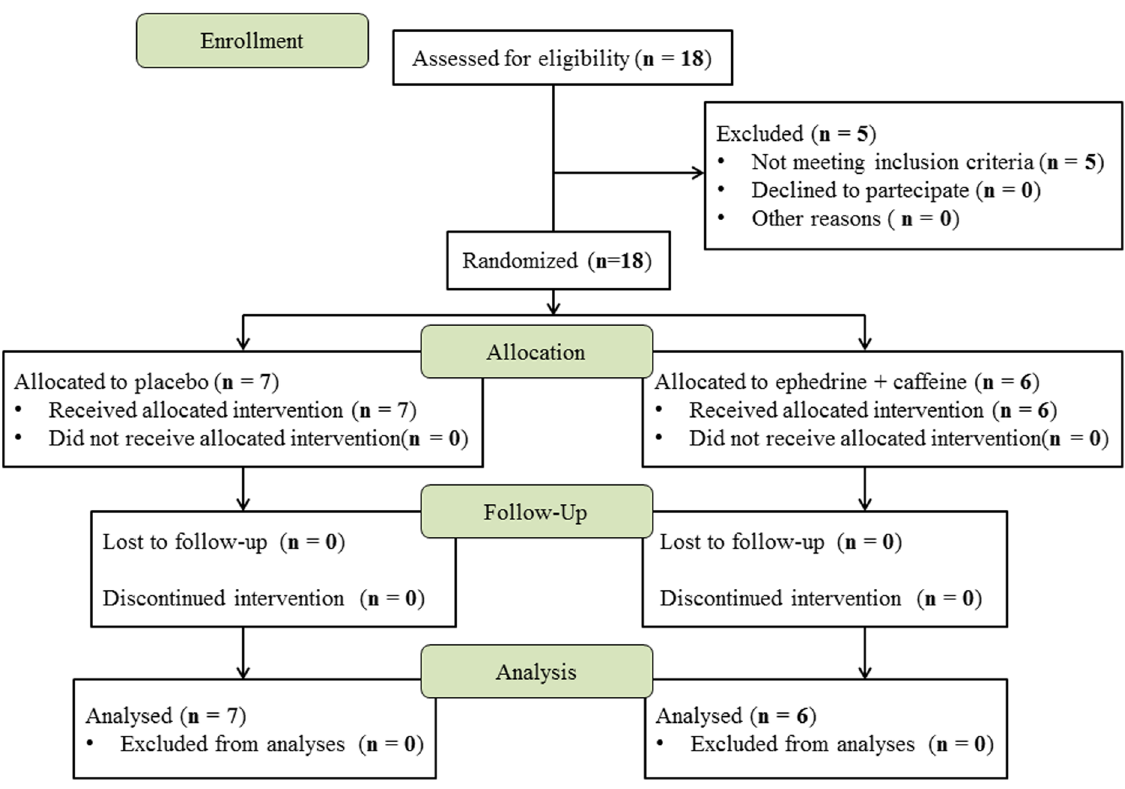
Figure 1. Flow diagram of patients’ enrollment and follow up.